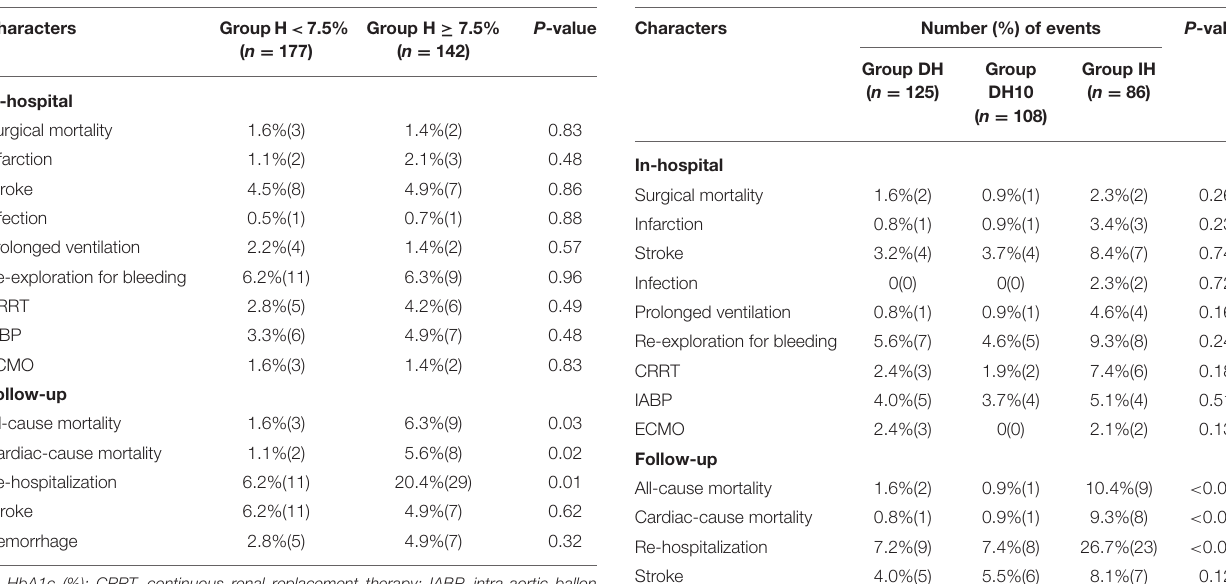
TABLE 4 | Clinical outcomes for study cohorts. TABLE 5 | Clinical outcomes for study cohorts.